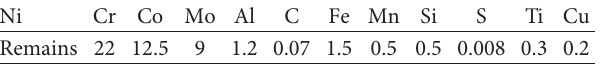
Table 1: Chemical composition of Inconel 617 alloy (wt.%).